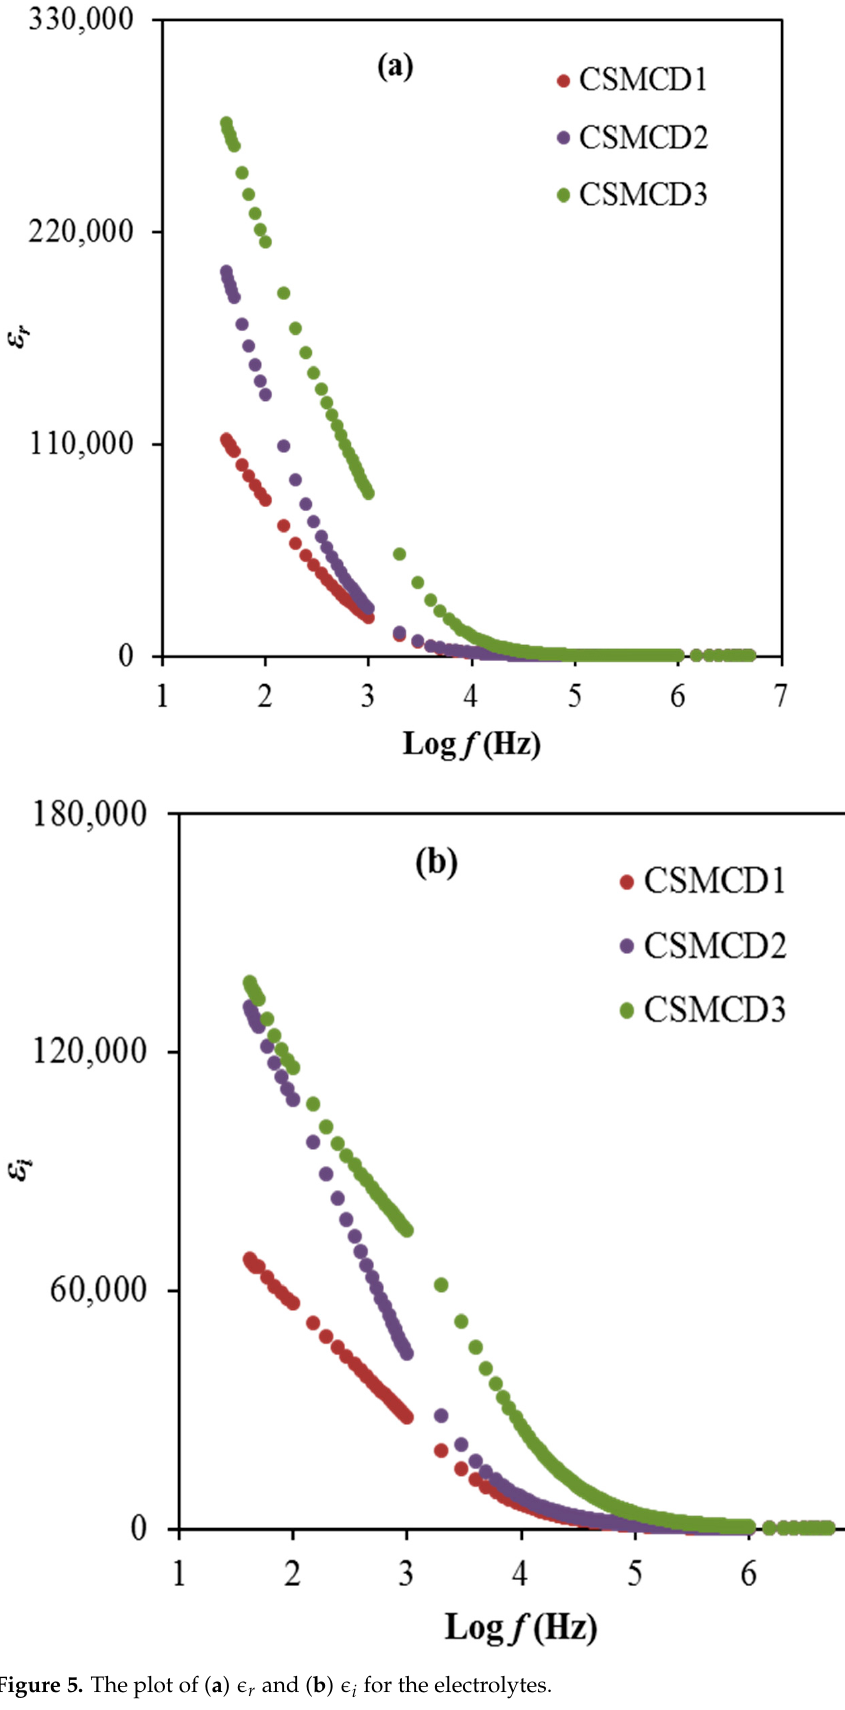
Figure 5. The plot of ( a ) ɛ r and ( b ) ɛ i for the electrolytes.